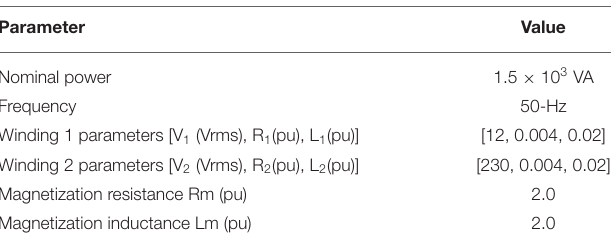
TABLE 1 | Parameters of distribution transformer. TABLE 2 | Parameters of the simulated distribution line.